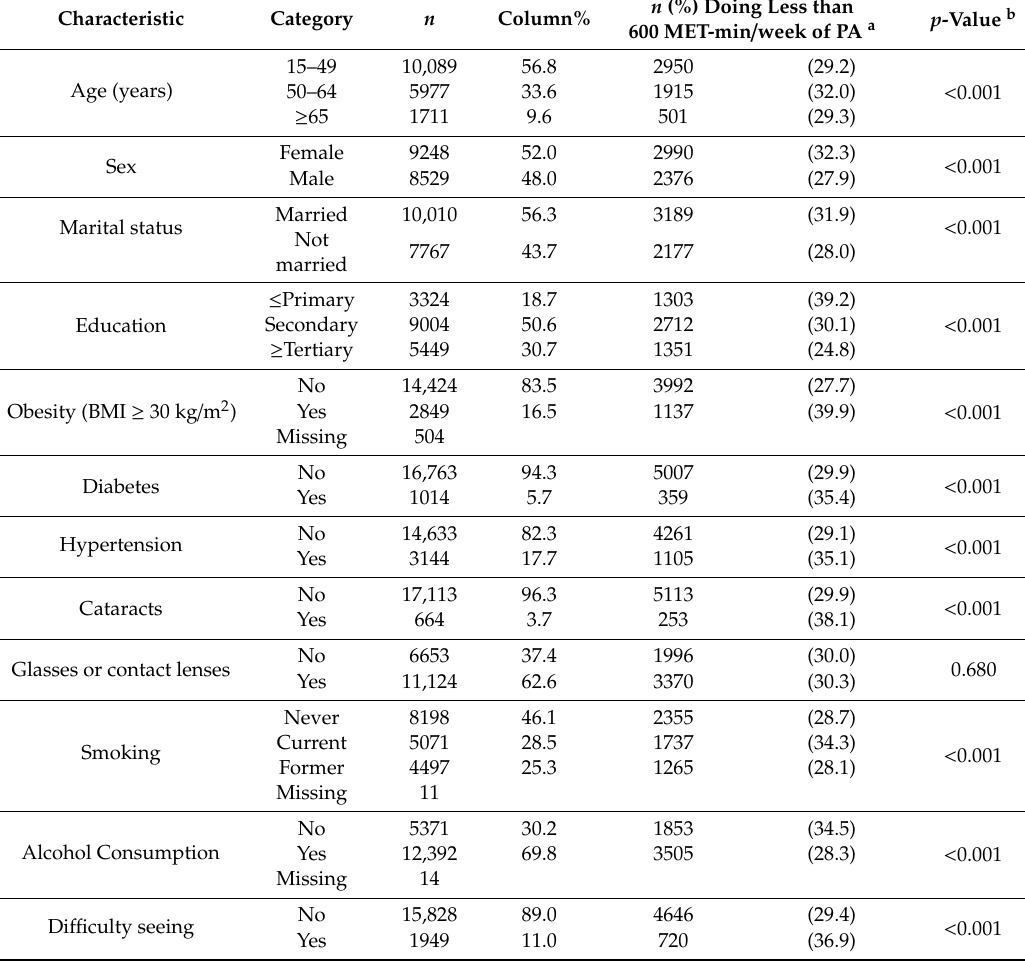
Table 1. Sample characteristics.